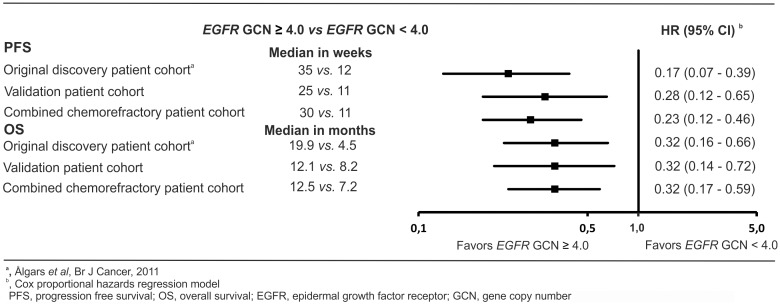
Progression-free survival and overall survival of anti-EGFR treated patients according to EGFR gene copy number.The hazard ratios and confidence intervals of the original discovery, validation, and combined chemorefractory patient cohorts are shown. A high EGFR GCN (IHC guided SISH) is associated with an improved disease outcome in all three KRAS wild type metastatic colorectal cancer patient cohorts treated with anti-EGFR therapy (two independent cohorts and one combined cohort of chemorefractory patients).